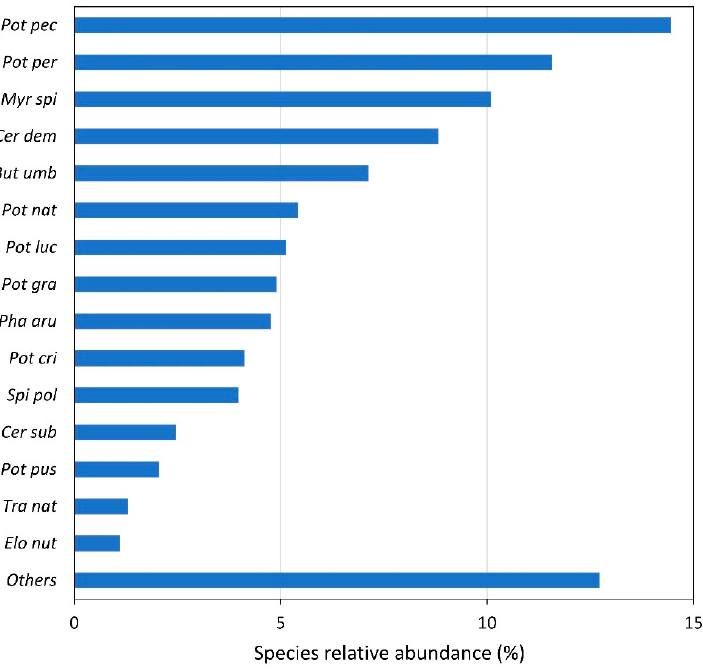
Figure 1. Relative values of total abundance of different species occurring in the Danube River. “Oth-